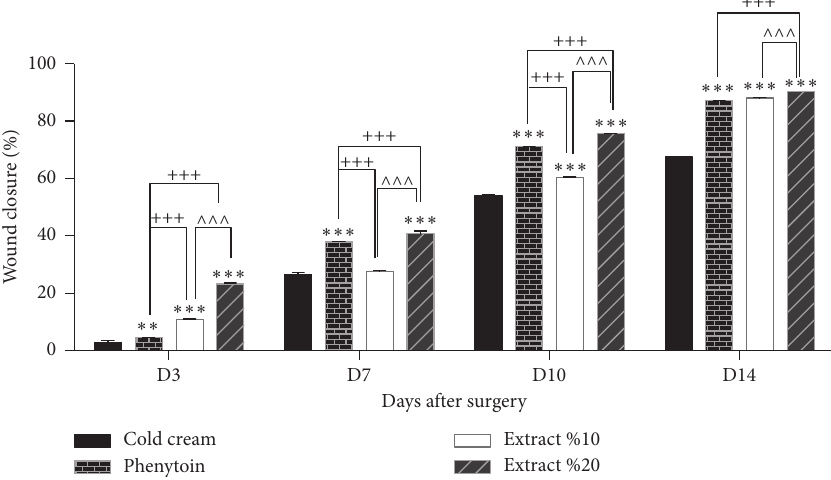
Figure 2: Wound closure percentage of different treated groups on different days after surgery. ∗∗ P < 0 . 05 and ∗∗∗ P < 0 . 001, vs. cold cream; +++ p < 0 . 001, vs. phenytoin; and ∧∧∧ P < 0 . 001, vs. extract